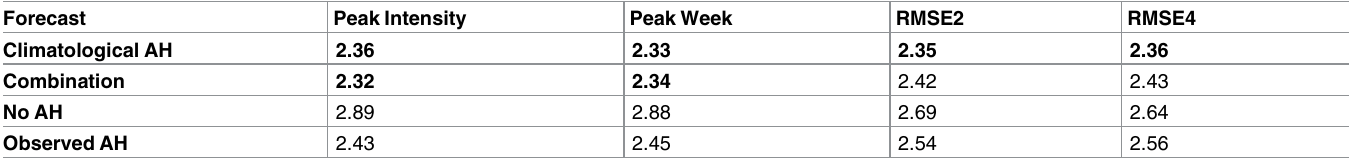
Table 1. Mean Friedman ranks of forecasterror for predictions of peak intensity, peak week and incidence during the first 2 weeks (RMSE2) and 4 weeks (RMSE4) of forecast. For pairwisetests of significancesee Table 2. Best performingmodel forms are in bold. Note, two forms may be best if not sta- tistically